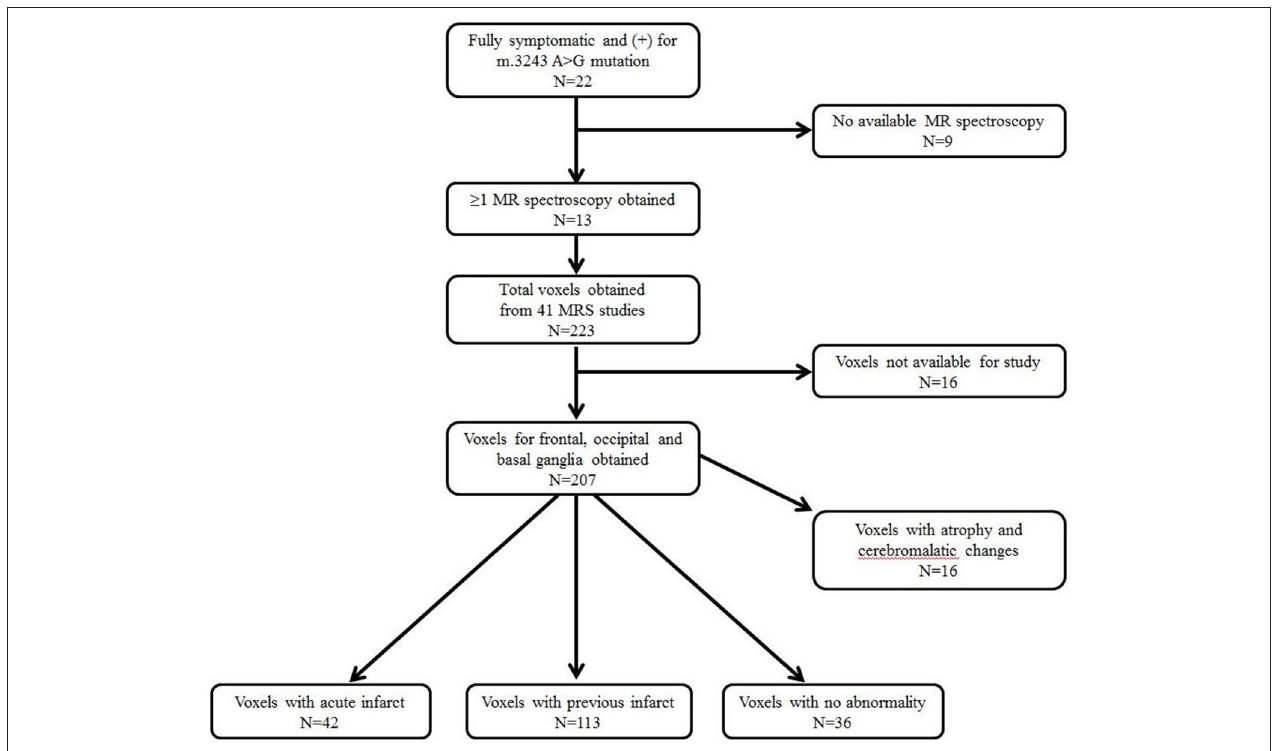
FIGURE 1 | Selection of patients and magnetic resonance spectroscopy (MRS)